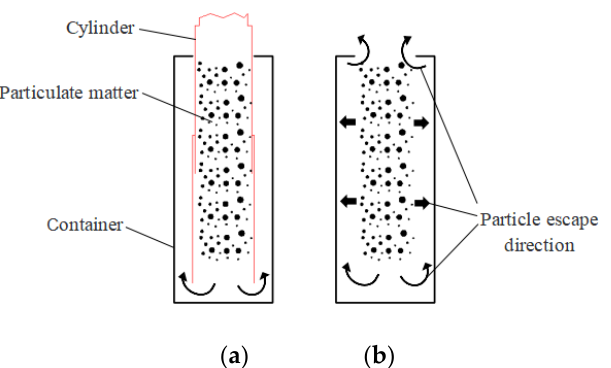
Figure 3. Comparison of different charging modes. ( a ) Dust escape characteristics under cylinder wall effect; ( b ) Dust escape characteristics under traditional charging method.